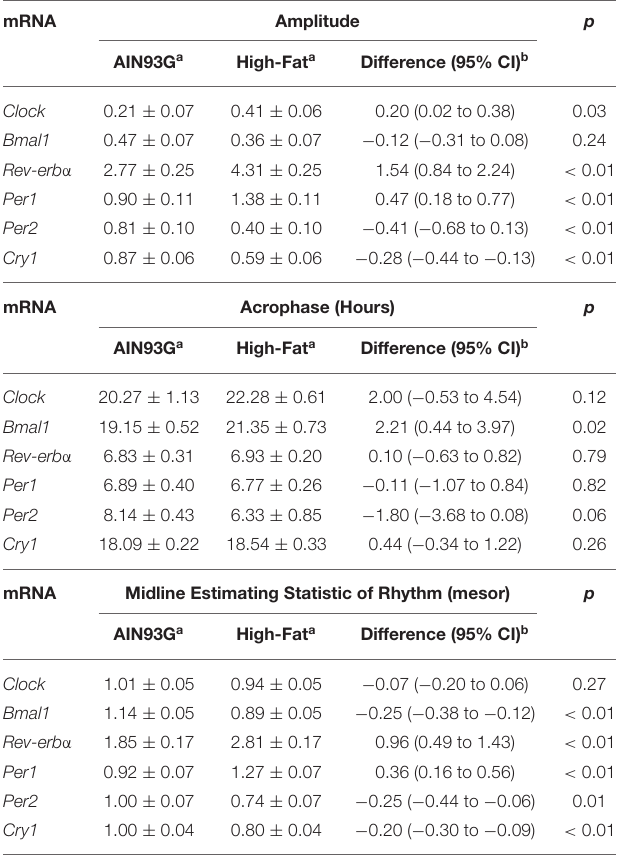
TABLE 2 | Estimated values obtained from the Cosinor model of fold changes in expression of circadian genes in mammary glands from pubertal mice fed AIN93G or high-fat diet.